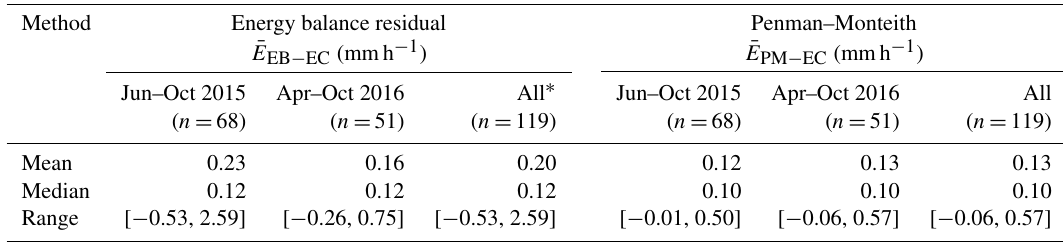
Table 5. Summary statistics for the wet evaporation rates estimated for the study period by different methods: energy balance ( ¯ E EB − EC ) and Penman–Monteith equation ( ¯ E PM − EC ).